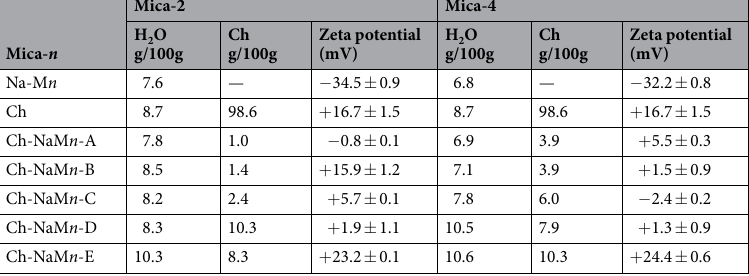
Table 1. Water content, chitosan content and zeta-potential of Ch-NaM n ( n = 2 and